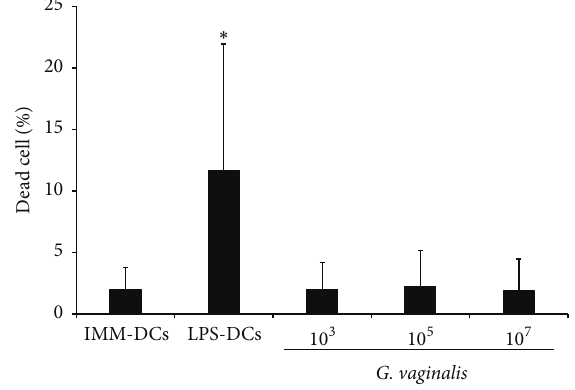
Figure 4: DC viability after 48 h of culture with G. vaginalis . Histogram shows the dead cell percentage, calculated from SSC/FSC diagram and live/dead marker. LPS induced a significant increase in DCmortalitycomparedtoimmatureDCsaloneinthemedium.Low and high concentrations of G. vaginalis did not induce any increase in DC mortality, even at a MOI of 100. Data are means (+ SD) from 6 individual experiments. Imm-DCs: immature DCs, LPS-DCs: DCs matured by a 48 h exposure to 100 ng/mL E. coli LPS; G. vaginalis. DCs matured after a 48 h incubation at different concentrations (10 3 to 10 7 CFU/mL, i.e., MOI = 0.01 to 100) of G. vaginalis. Friedman’s test with Nemenyi’s comparison ∗ 𝑝 < 0.05